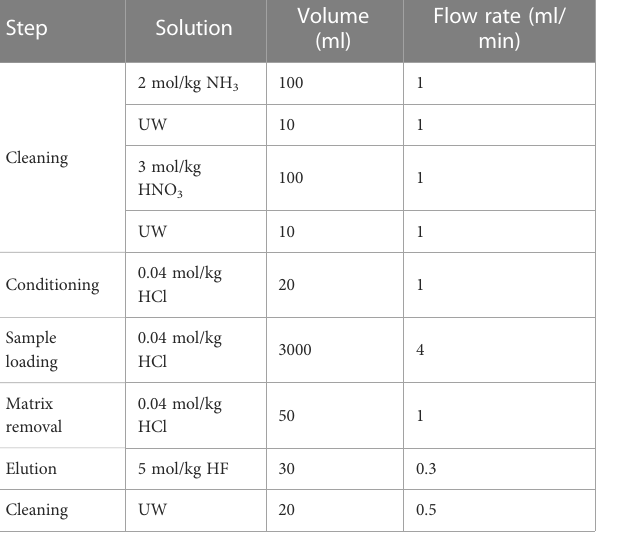
TABLE 1 Procedure of chelating solid-phase extraction with TSK-8HQ.